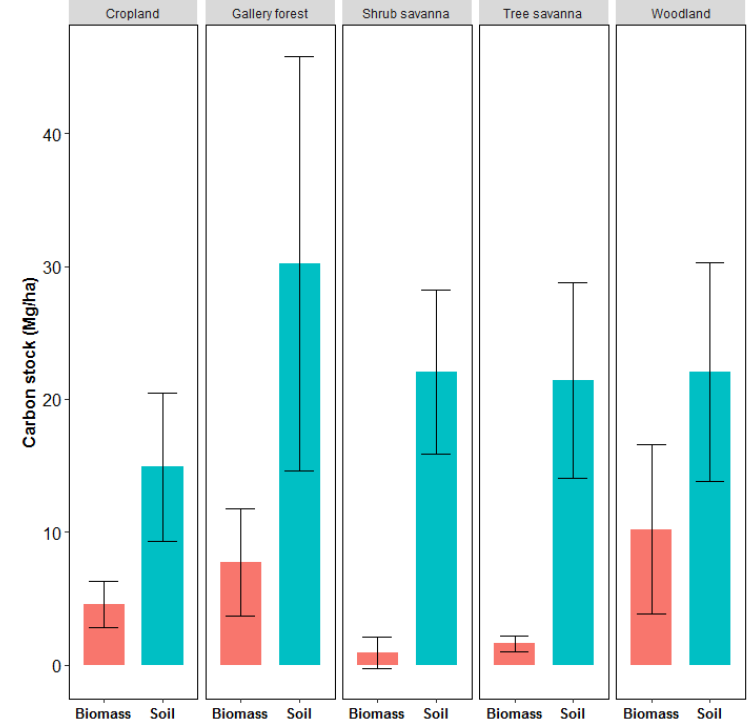
Figure 5. Estimated carbon stock across the different LULCc.